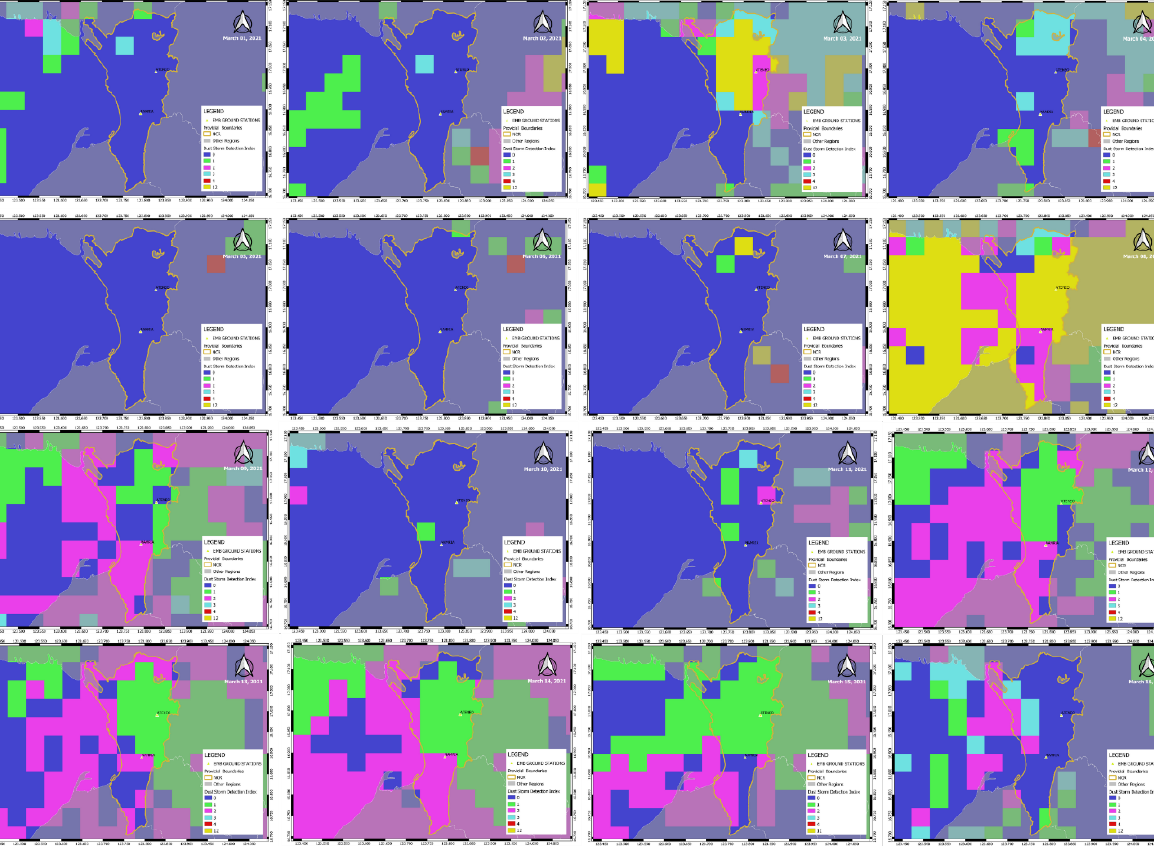
Figure 12. Mean FY-4A daily DSD from 03/01 to 03/16, 2021.